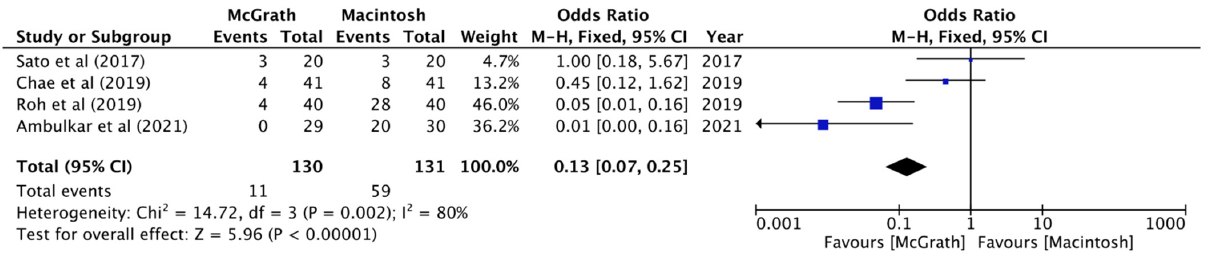
Figure 6. Forest plot of the external laryngeal pressure maneuver used (McGrath vs. Macintosh laryngoscope).